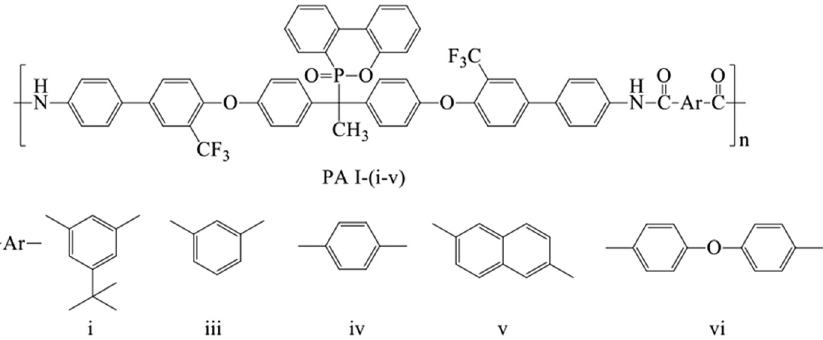
Figure 13: Structure of the PAs containing DOPO moiety PA I -( i - vi ) ( 83 ) .